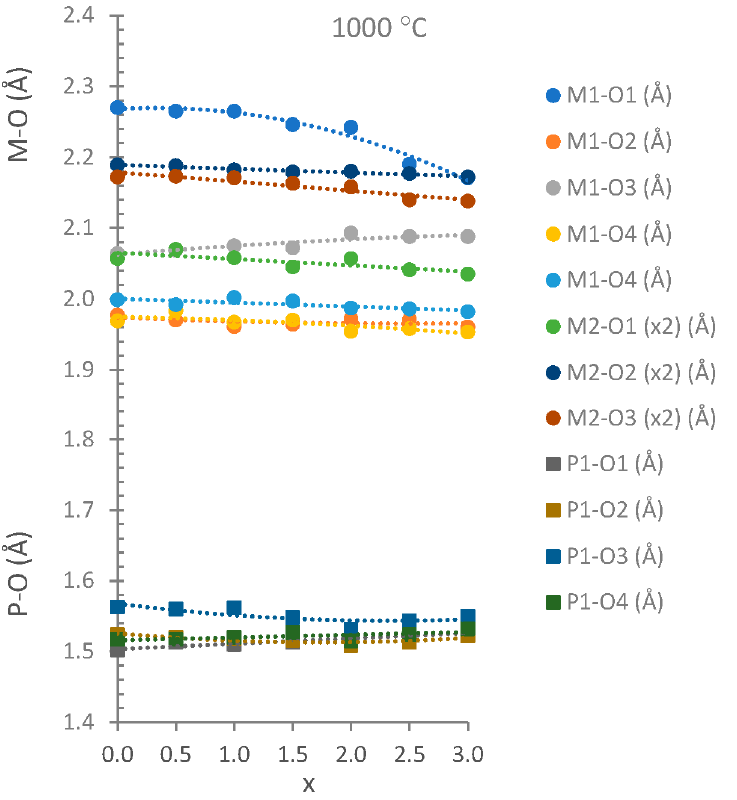
Figure 4. M-O (circles) and P-O (squares) distances in the stable Co 3 P 2 O 8 structure at 1000 °C.